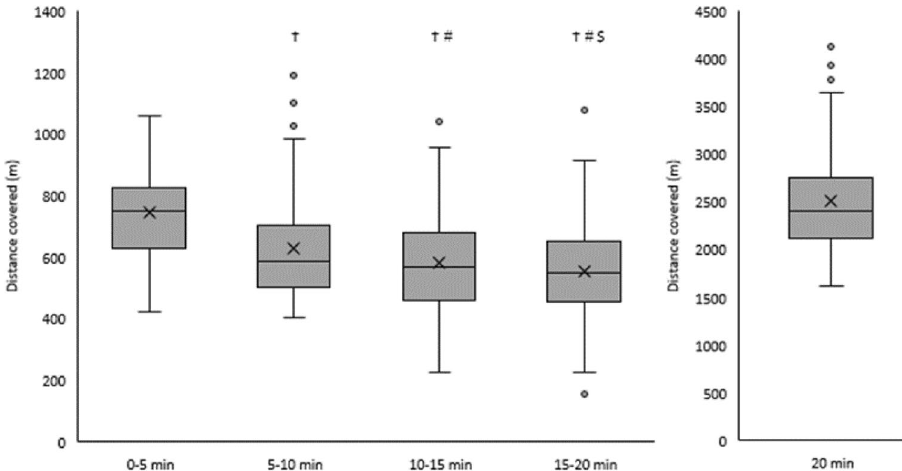
Figure 1. Distance covered (m) by participants during each 5 min split, and the total 20 min, of The Daily Mile. Boxplots represent the median (centre line), mean (cross), inter-quartile range (grey box), range (whiskers) and outliers (grey circles). Main effect of time, p < 0.001. Ϯ Denotes significant difference from Split 1. # Denotes a significant difference from Split 2. $ Denotes a significant difference from Split 3 (all p < 0.05).